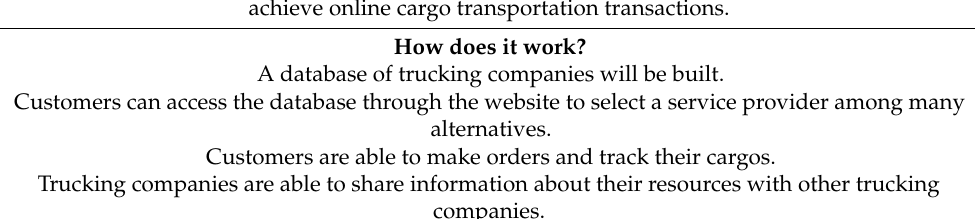
Table 1. Conceptual prototype of the proposed system for cargo transportation.